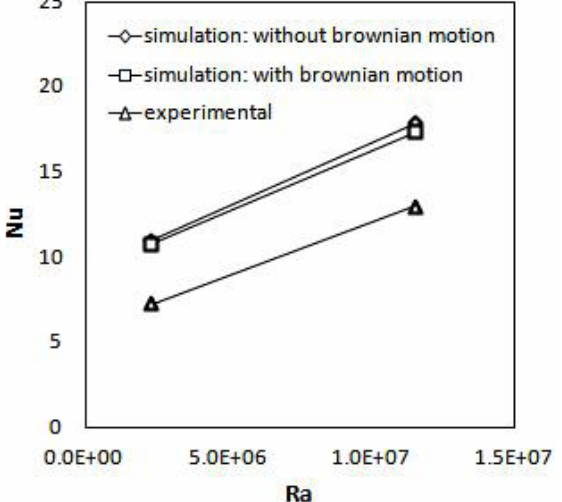
Fig. 7. Variation of Nusselt number with Rayleigh number for Ø